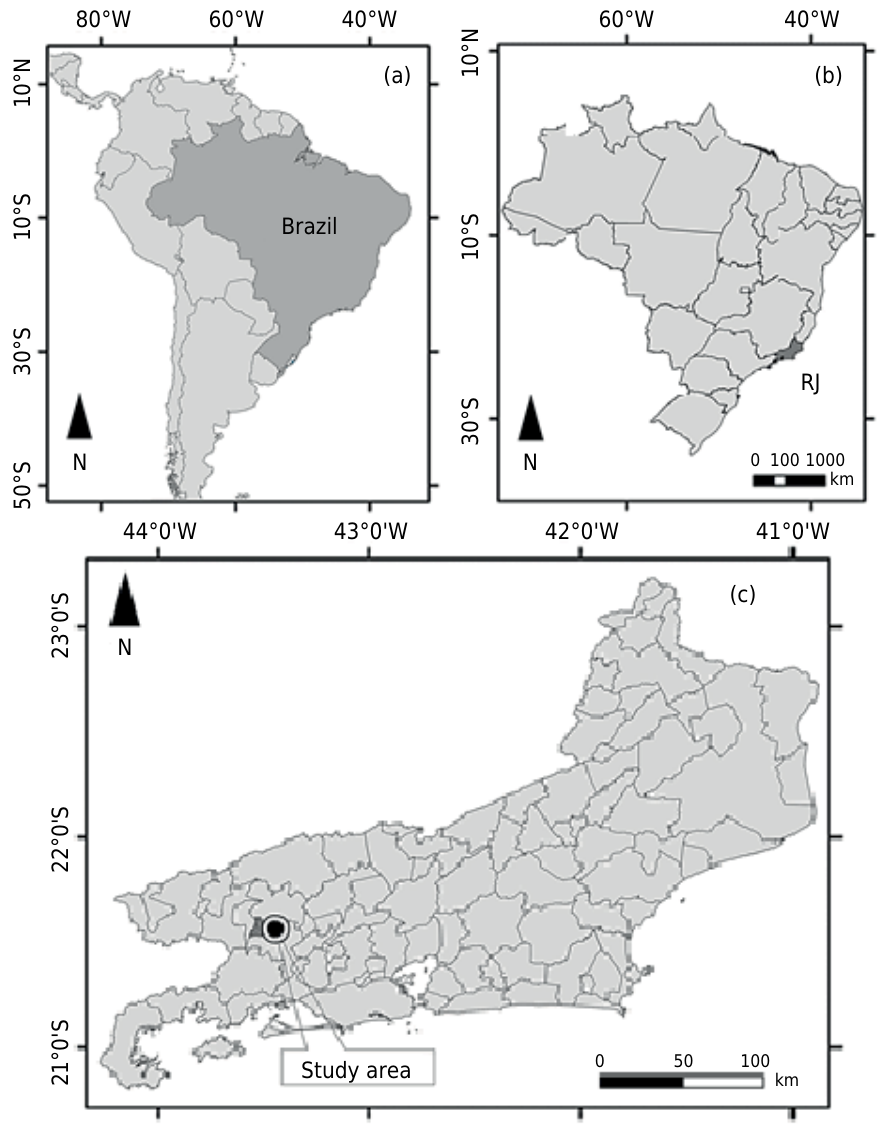
Figure 1. Localization of the studied area in Pinheiral, Rio de Janeiro State, Southeastern